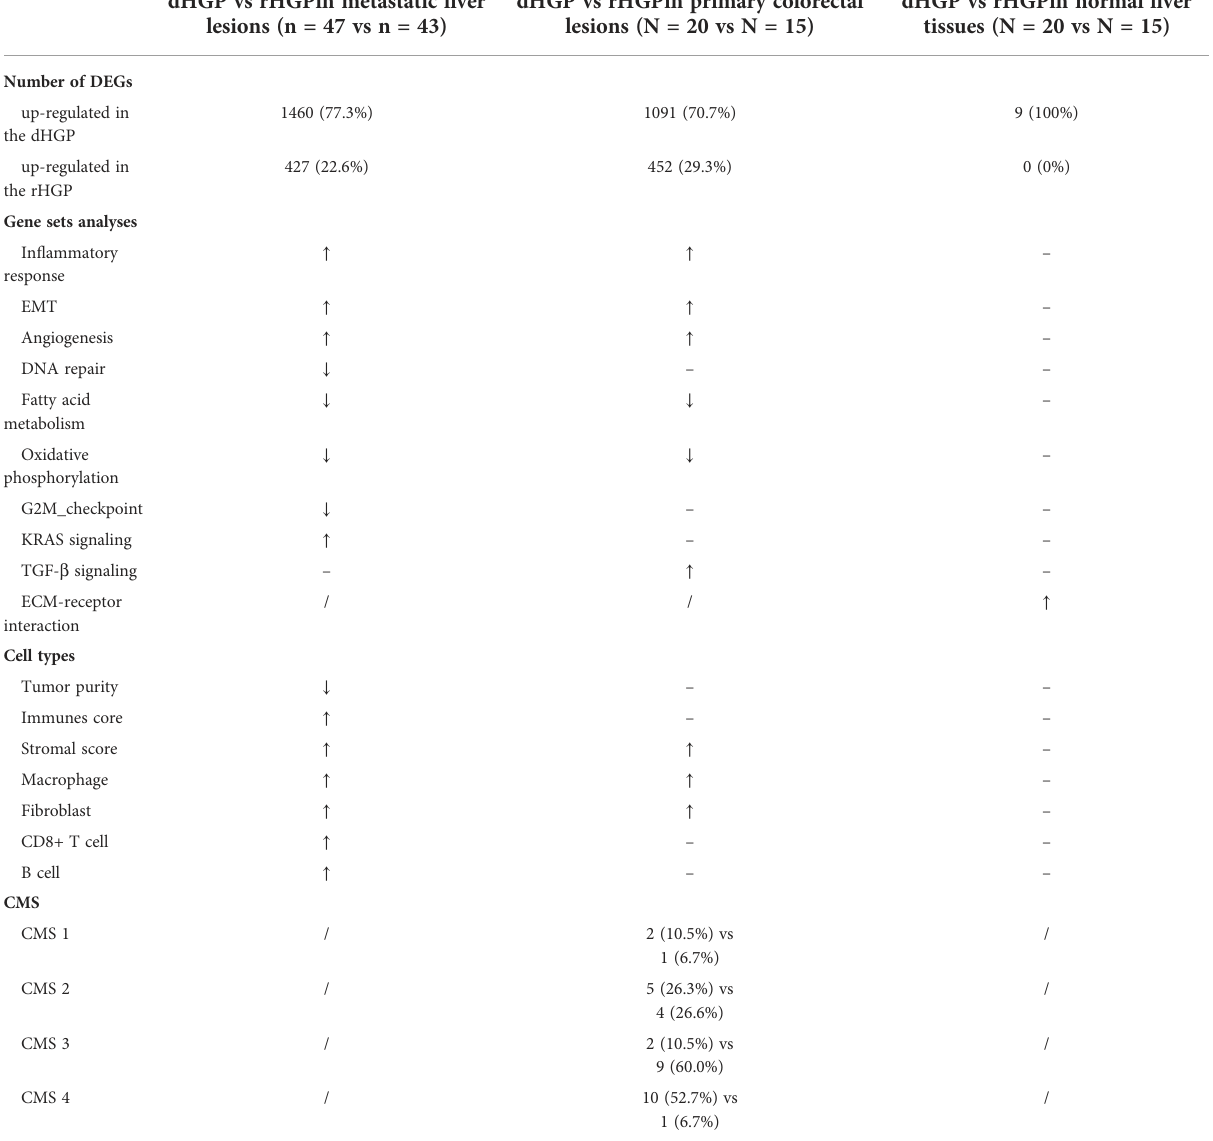
TABLE 2 The mainly comparison of the transcriptome landscapes between the dHGP and